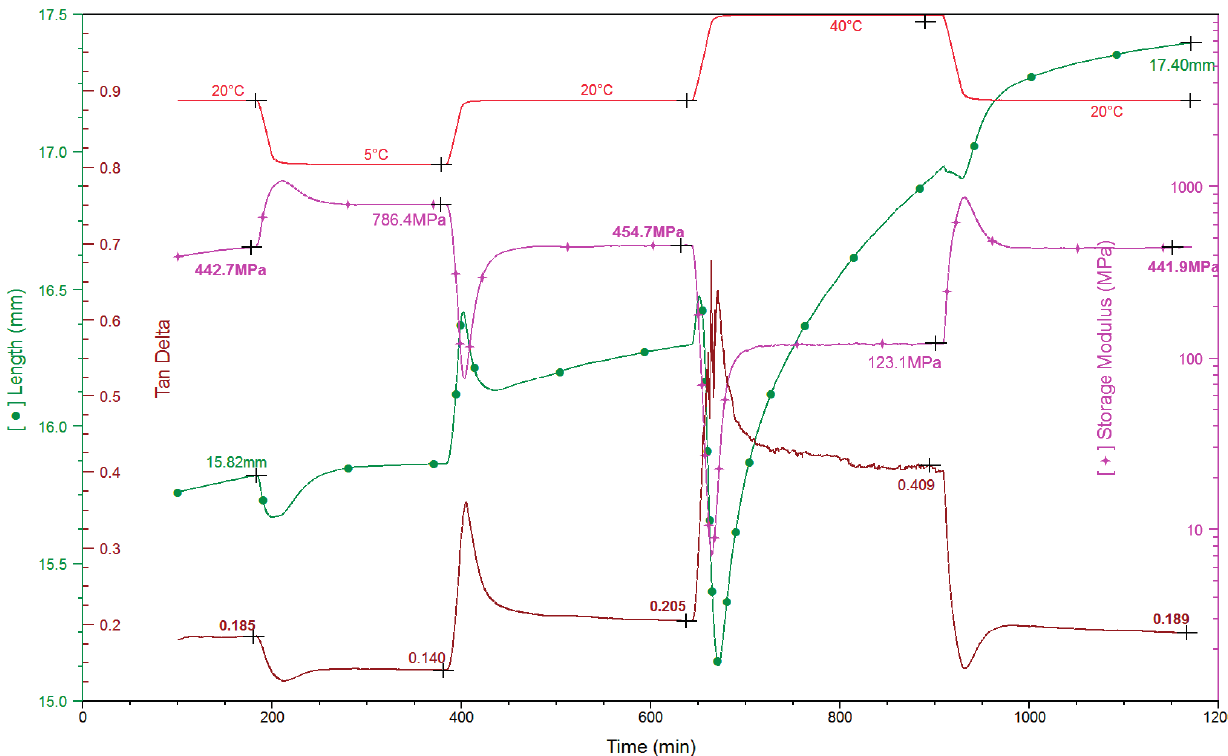
Figure 10. T -steps at 50% RH for a 0.042 mm CaCas/Gly film: dynamic mechanical variations due to fast T and H( T ) changes between 5 and 40 °C. Legend: green ( ● ) = L ; pink ( + ) = E '; red ( − ) = T ; brown ( − ) = Tan δ